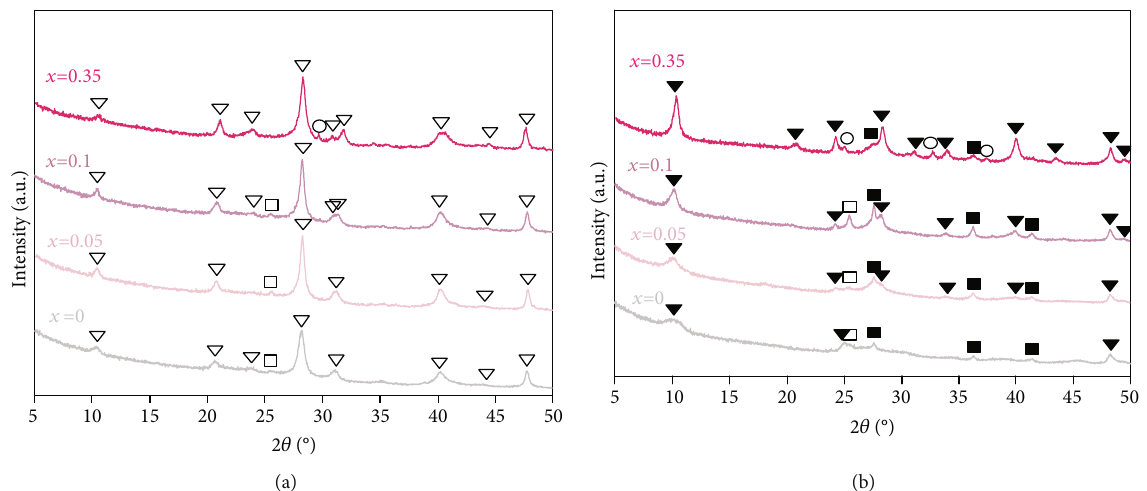
□ □ Ti O , ▼ : H Ti O , □ : TiO 0 : 7 1 : 825 0 : 175 4 0.7 1.825 0.175 4